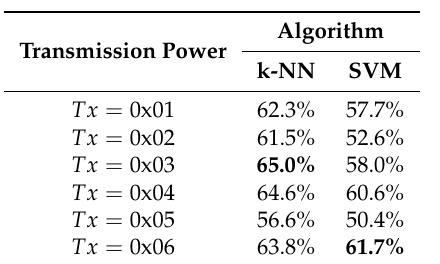
Table 3. Global accuracy using BLE4.0 antenna for k-NN (with k = 5) using mode and SVM (with a quadratic polynomial kernel function) algorithms for different transmission power ( Tx ) levels. Best results are shown in